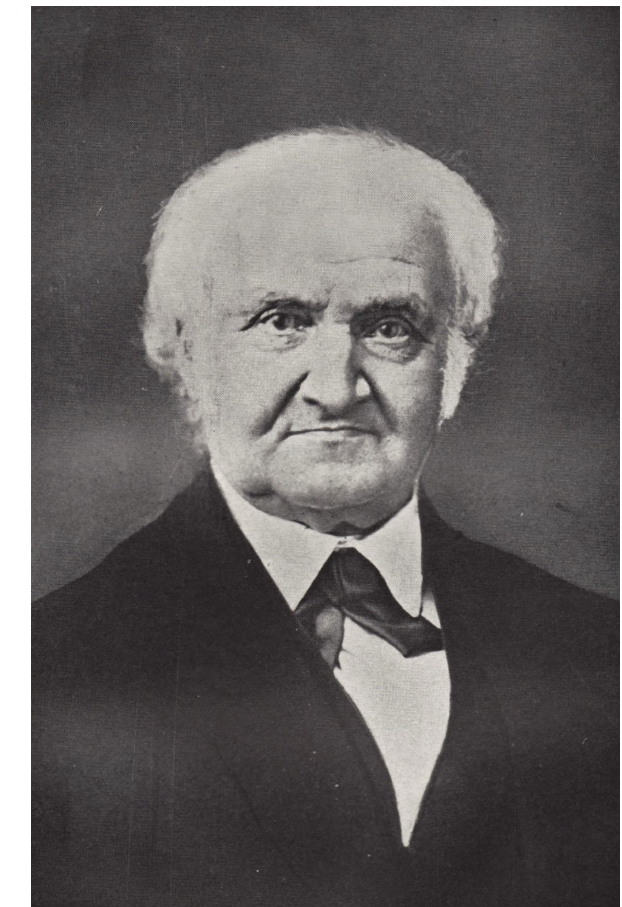
Figure 1. Eduard Heis (1806–1877; Plaßmann, 1930).